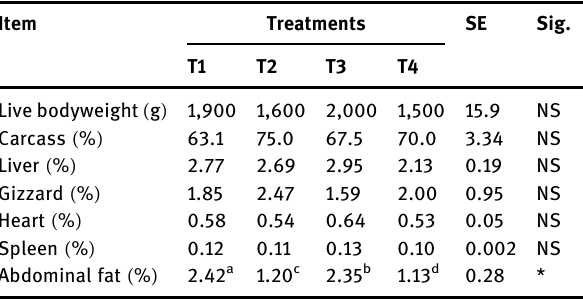
Table 4: Carcass and relative weight of organs as a ff ected by using AgNPs and their NP capping by acetic acid in broiler chickens